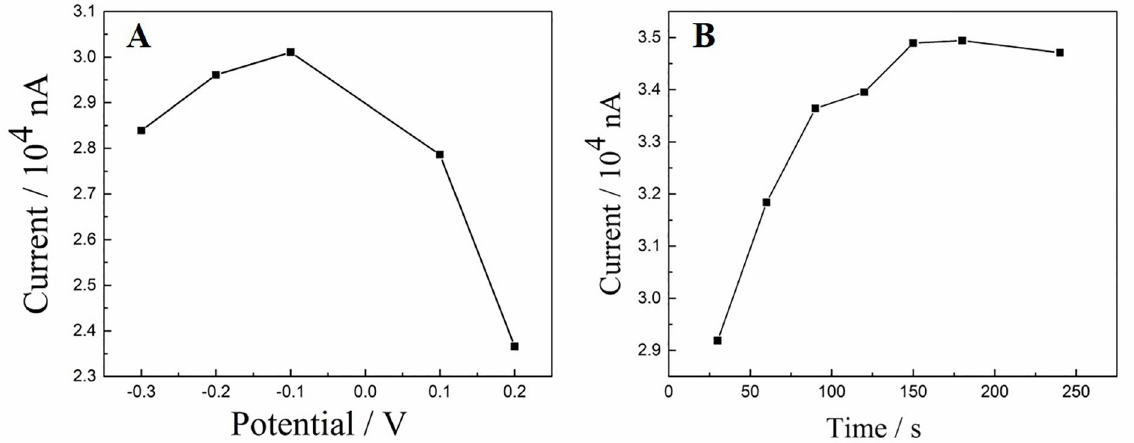
Figure 6. The effect of accumulation potential ( A ) and accumulation time ( B ) on the oxidation peak current of 1 × 10 − 5 mol/L